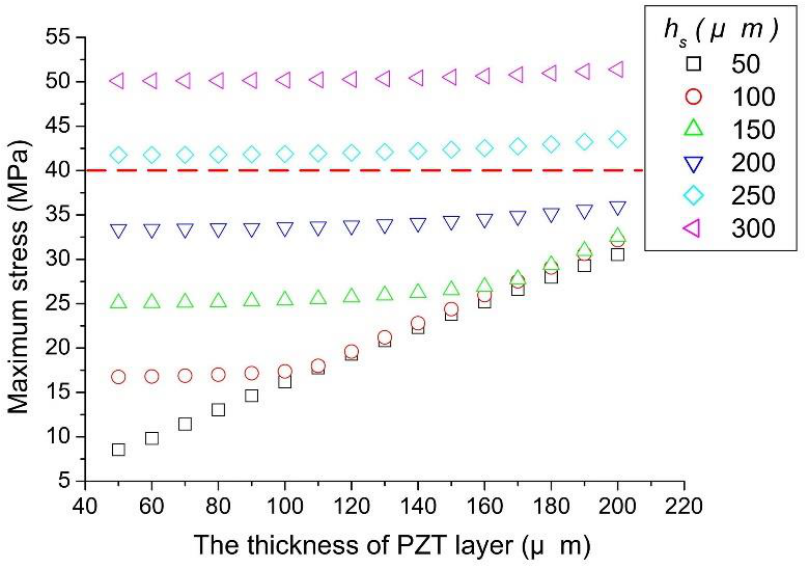
Figure 8. The simulation result for the thickness of the PZT layer vs. maximum stress.